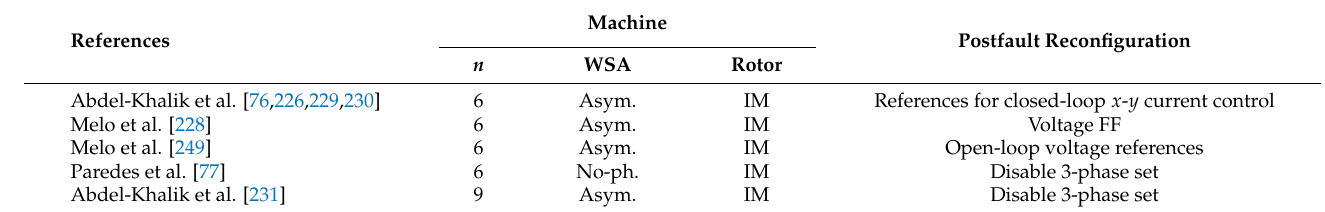
Table 5. Methods based on open-loop V/f control for tolerating phase OCs (Section 3.2) in multiphase applications in the